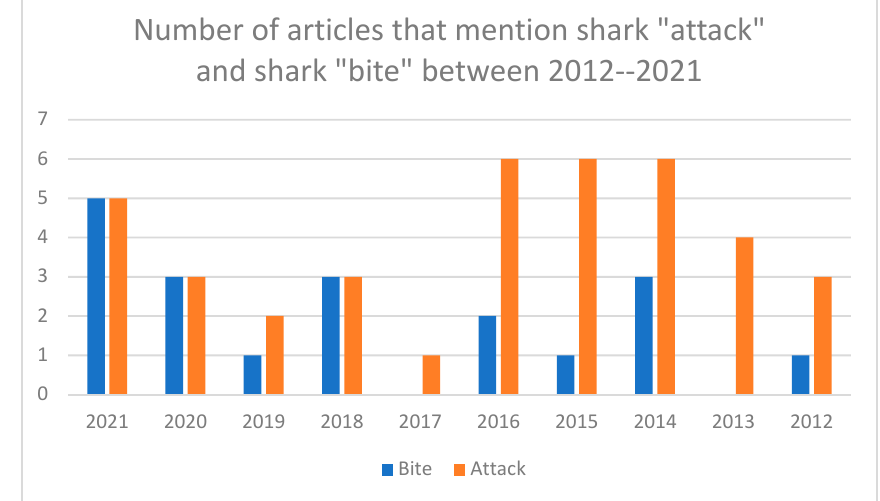
Figure 3. Contains data on the number of articles per year that mention each descriptor for human– shark interactions (n = 36).